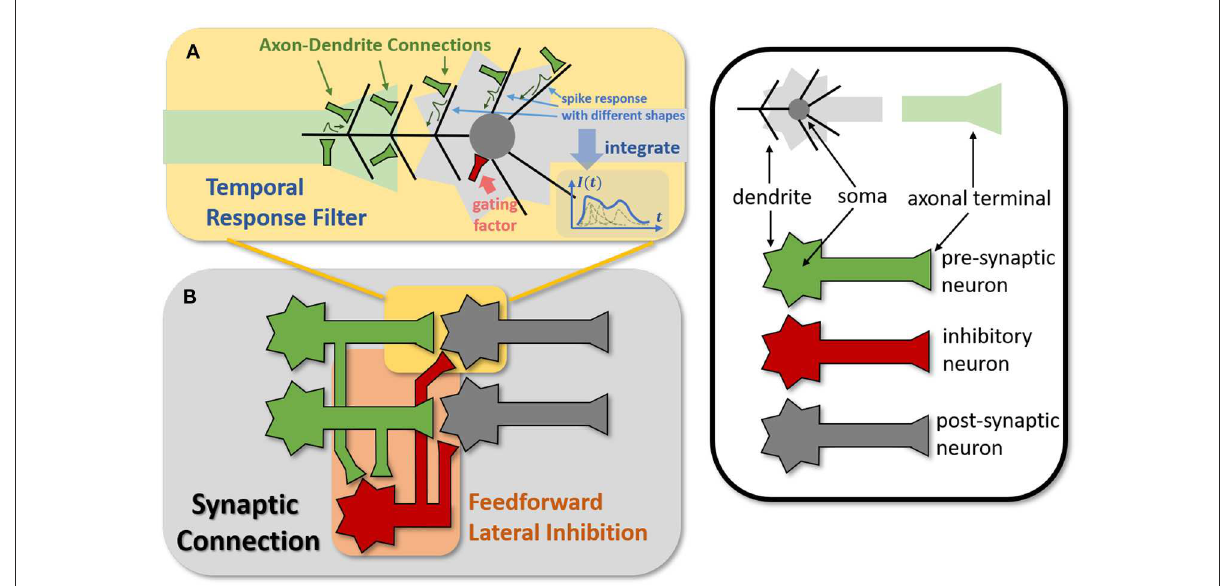
FIGURE4 Modeling TRF and FLI modules from biological circuits into computational models. (A) The motivation of TRF that integrating multi-compartment axon-dendrite connections with different spike responses into a single linear response filter. (B) The function of FLI that transmitting the spike activities of pre-synaptic neurons into inhibitory neurons to obtain gating factors.